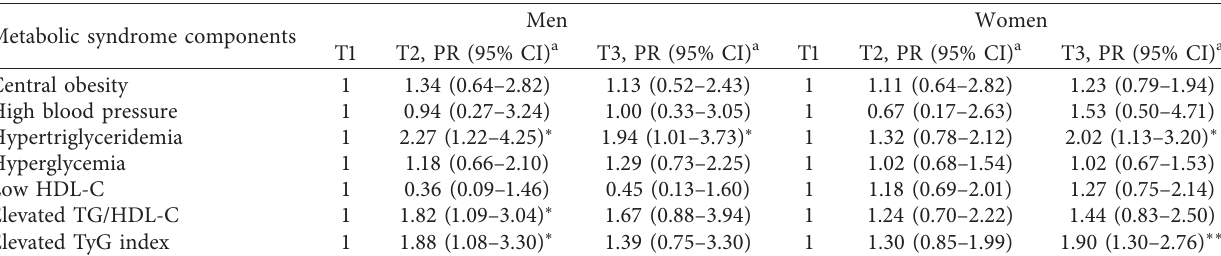
Table 2: Association between SUA tertiles and MetS components and insulin